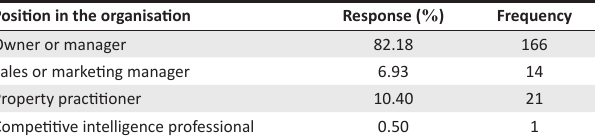
TABLE 7: Percentage response and frequency of positions held in the organisation ( N = 202). Position in the organisation